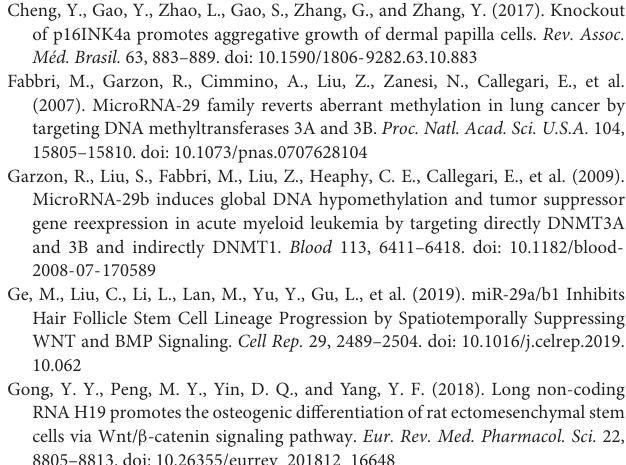
TABLE S2 | Primers used to detect the expression of mRNAs in dorsal skin in NU/NU mice. TABLE S3 | Proteins binding with lncRNA H19 by biotin-labeled RNA pull-down and mass spectrometry analysis in DP cells (the figures in the Match an Sequence columns represent the number of scores higher than Confidence